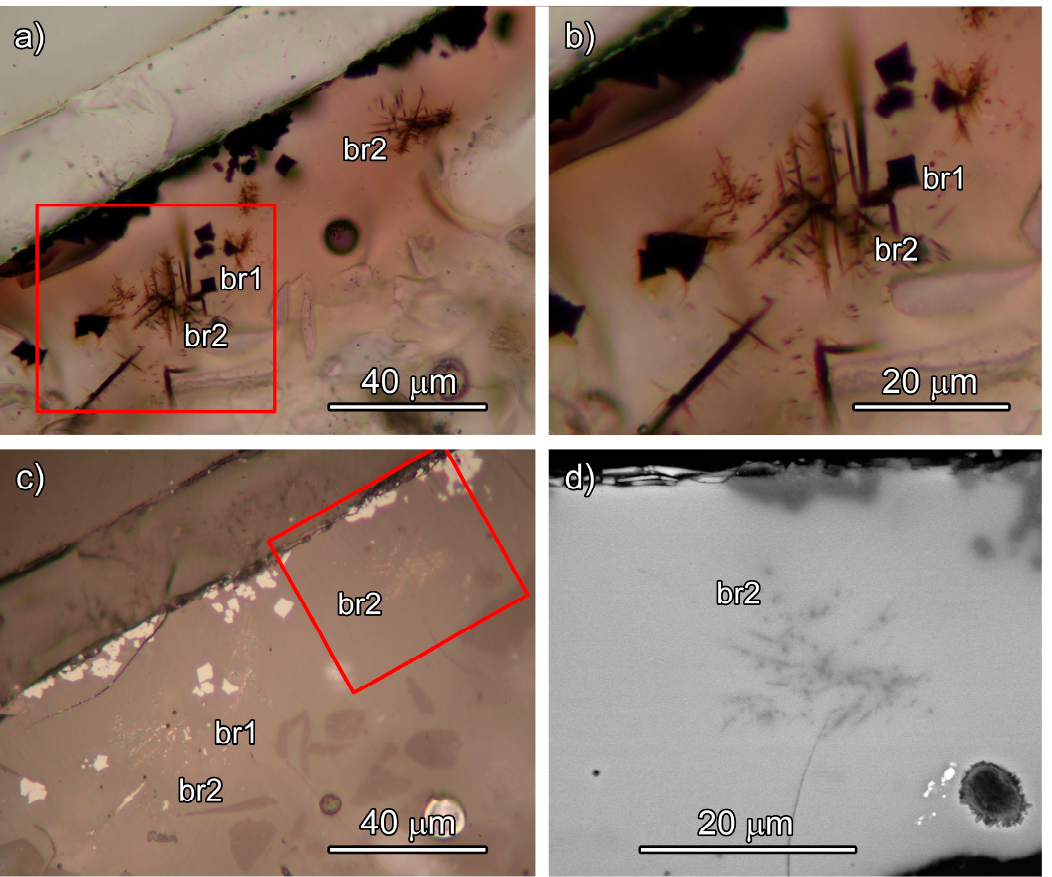
Figure 3. ( a ) A photomicrograph of the brown decoration area (TL): Dark brown bipyramidal crystallites (br1) and brown thin needle-like crystals of braunite (br2) can be observed. The picture